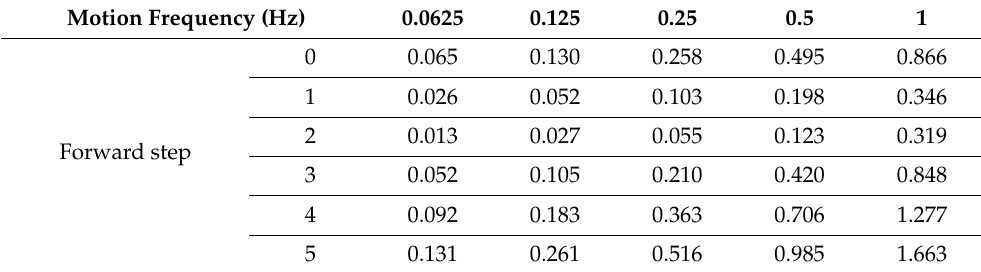
Table 2. Amplitude deviation with different numbers of prediction steps ( ω s = 10 Hz).